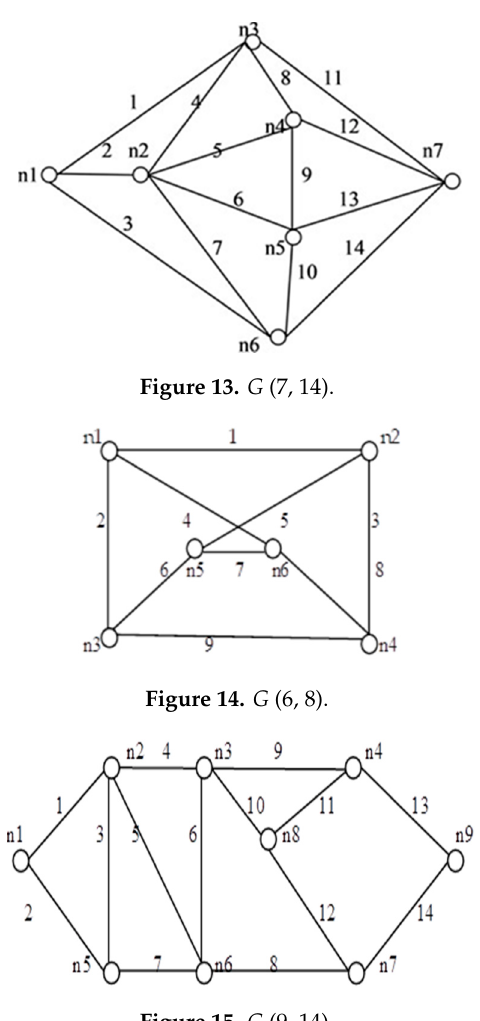
Figure 15. G (9, Figure 15. G (9, 14).